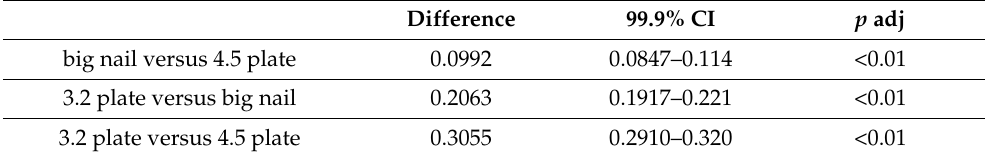
nail, the 3.2 plate stands for small additional plates, and the 4.5 plate stands for large additional plates.